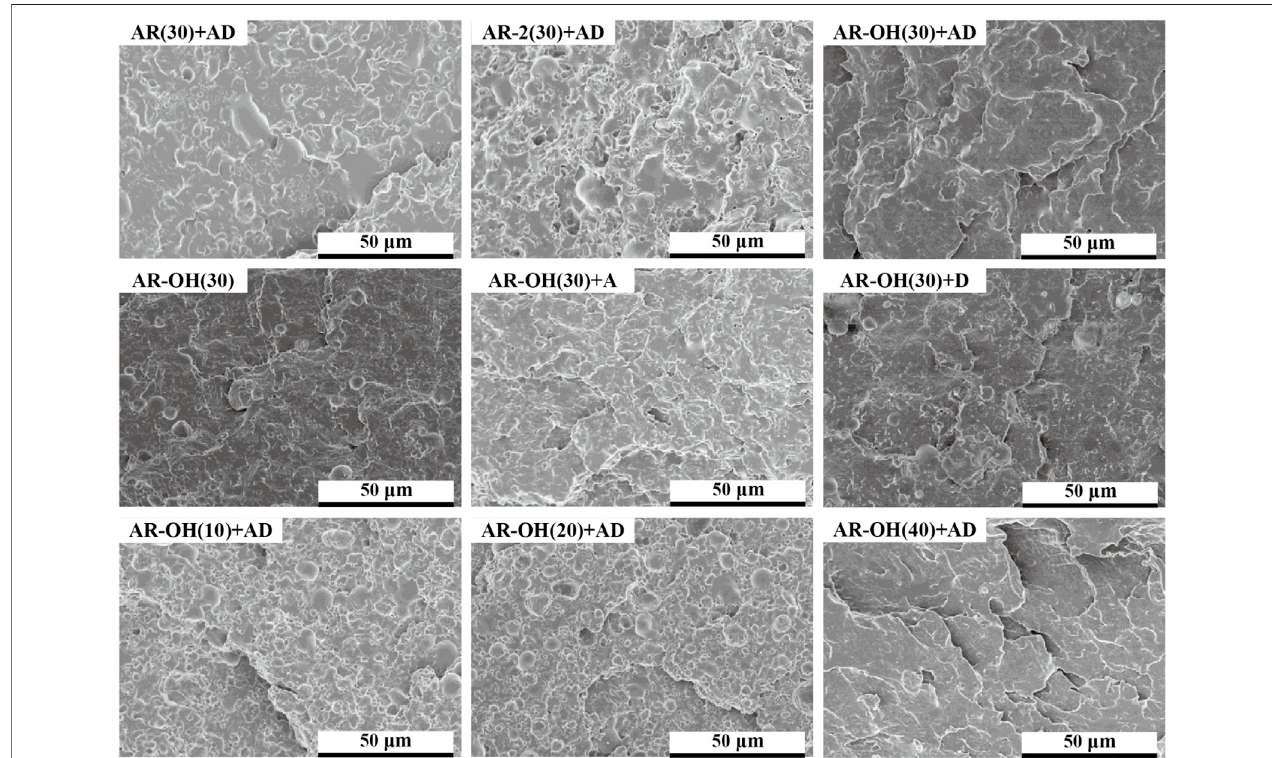
FIGURE 7 | SEM images of the impact fracture surfaces of the PLA/ i -BIIRs blends.